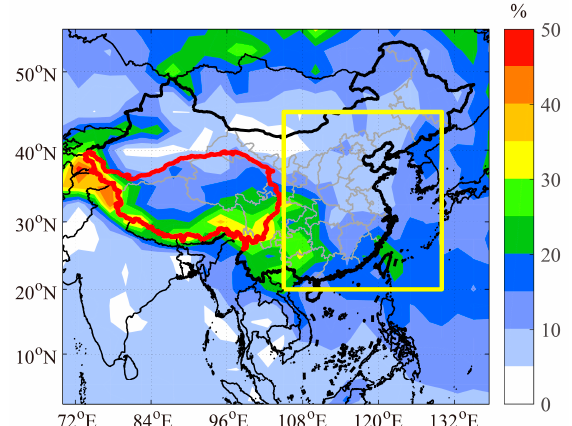
Figure 1. Spatial distribution of the frequency of occurrence of Sc clouds detected by CloudSat from June 2006 to December 2010. The yellow rectangular box indicates the area of interest in this study, and the thick red contour denotes the edge of the Tibetan Plateau.